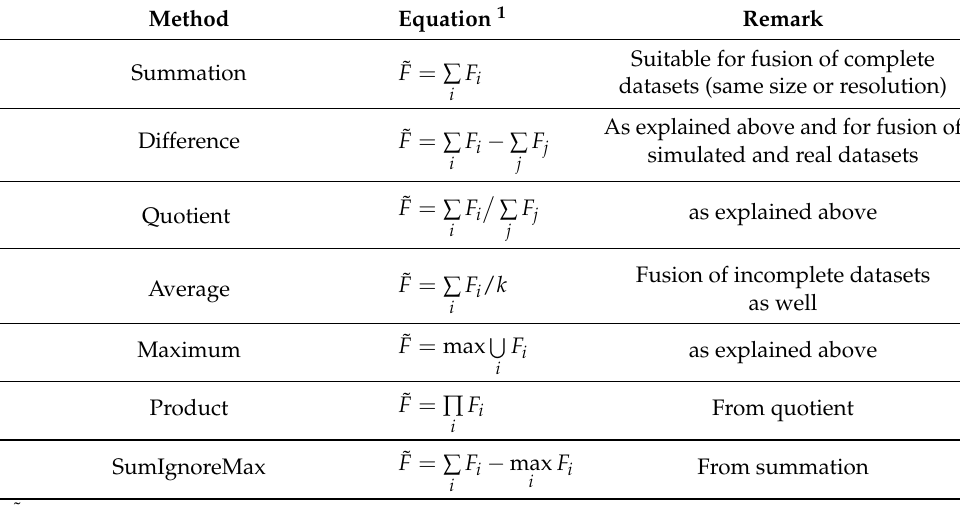
Table 3. Data fusion operations at signal level